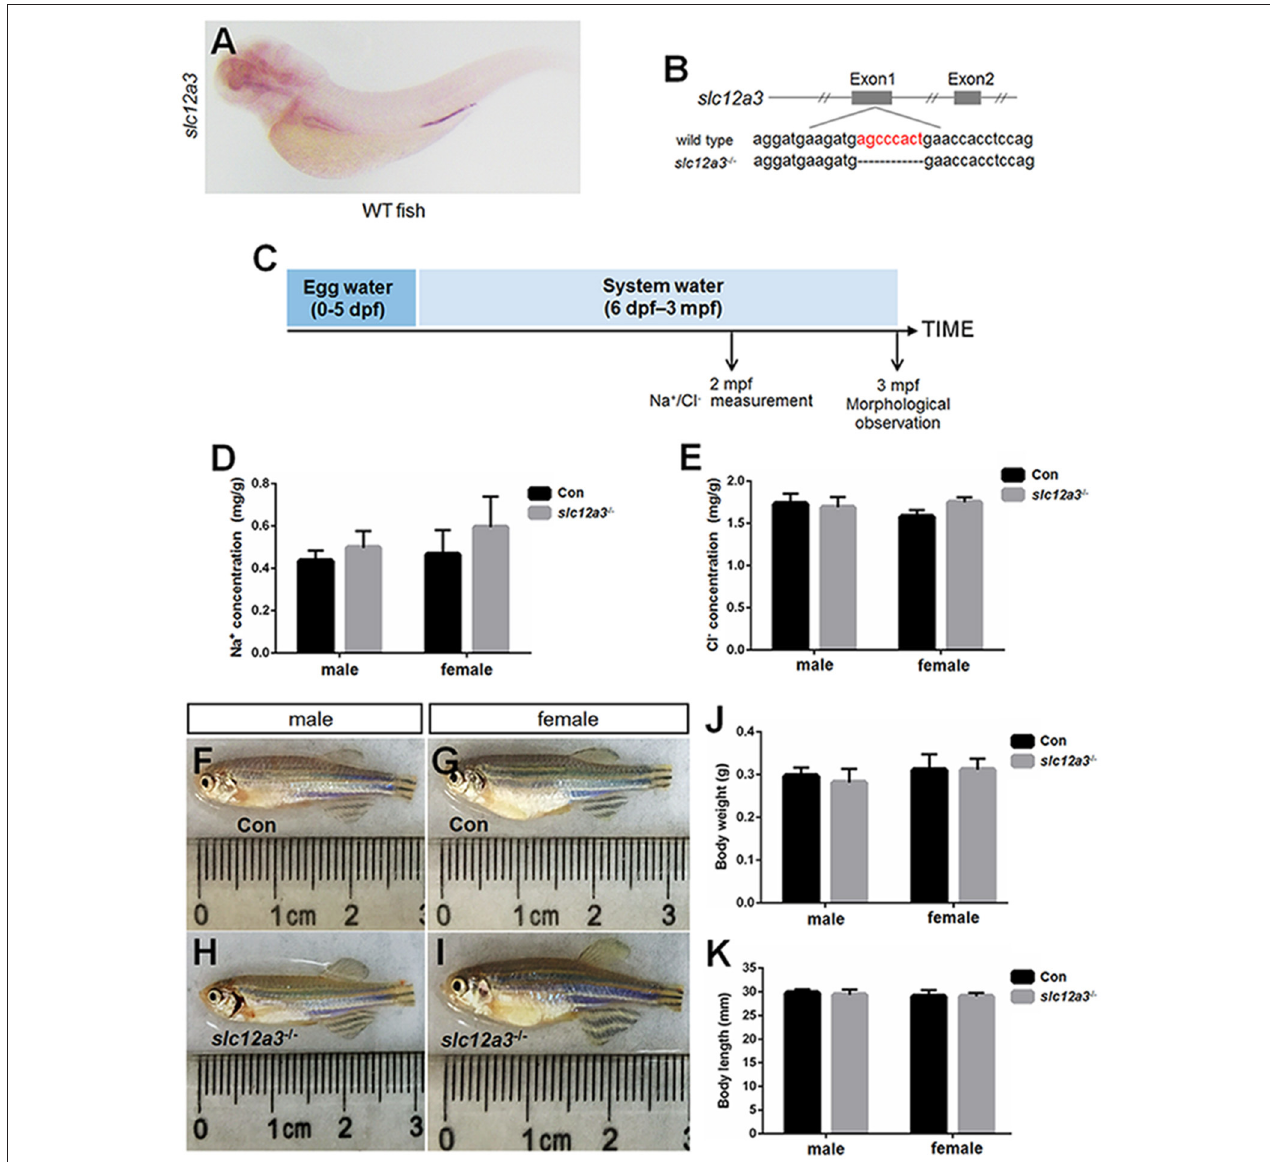
FIGURE 5 | Generation of slc12a3 -deficient zebrafish. (A) WISH analysis using the slc12a3 probe in wild-type larvae at 4 dpf. (B) Targeted depletion of the slc12a3 gene. The CRISPR/Cas9 target site is located at exon 1. A genotype with an 8-bp deletion was used to establish the slc12a3 knockout line (highlighted in red). (C) Schematic diagram of the rearing timeline. Larvae were reared in egg water from 0 to 5 dpf and in system water after 5 dpf. The fish at 2 mpf were harvested for Na + and Cl − measurements. The fish at 3 mpf were harvested for morphological observation. (D,E) Na + and Cl − concentrations were measured in control and slc12a3 -deficient male and female fish at 2 mpf, respectively. (F–I) The general morphological observations of control and slc12a3-deficient male and female at 3 mpf, respectively. (F,G) Male and female control fish at 3 mpf. (H,I) Male and female slc12a3 -deficient fish at 3 mpf. (J,K) Body weight and body length of control and slc12a3 -deficient male and female at 3